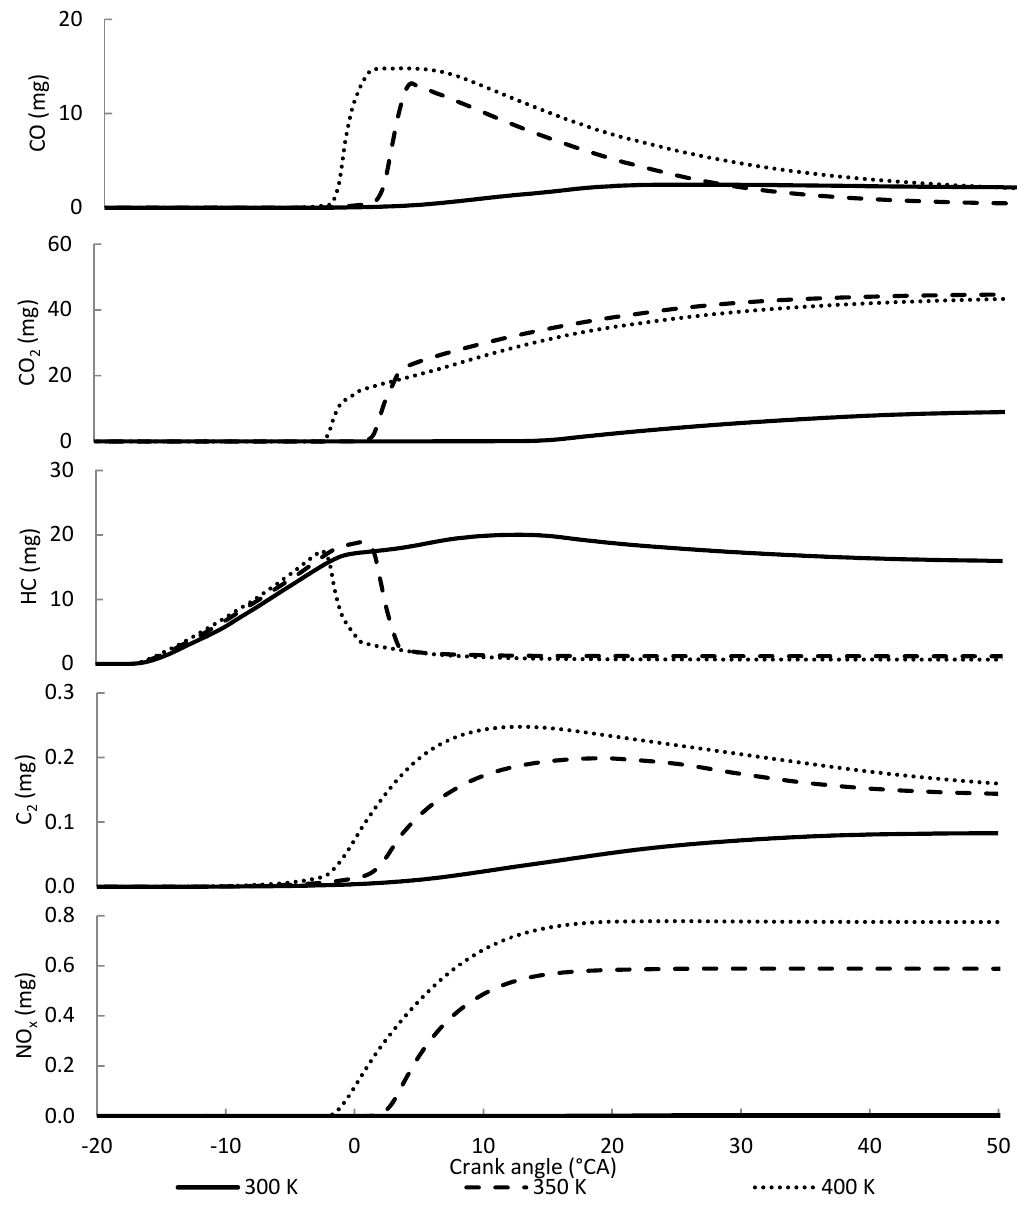
Figure 16. Emission graphs of D50E40B10 blend running at 1600 RPM at different intake temperature.